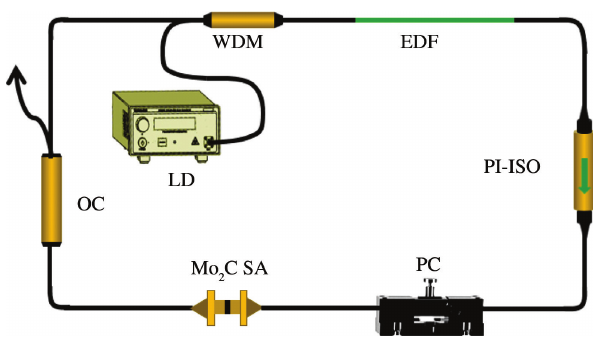
Figure 3: Schematic diagram of passively mode-locked erbium-doped fiber (EDF) laser